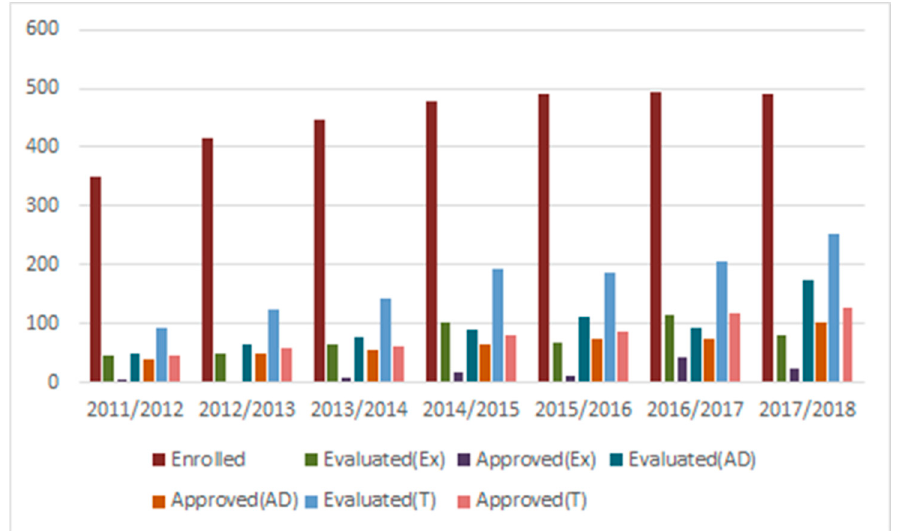
14 of 19 Figure 8. Pass rates distribution (AD, Ex, T): Biomedical.